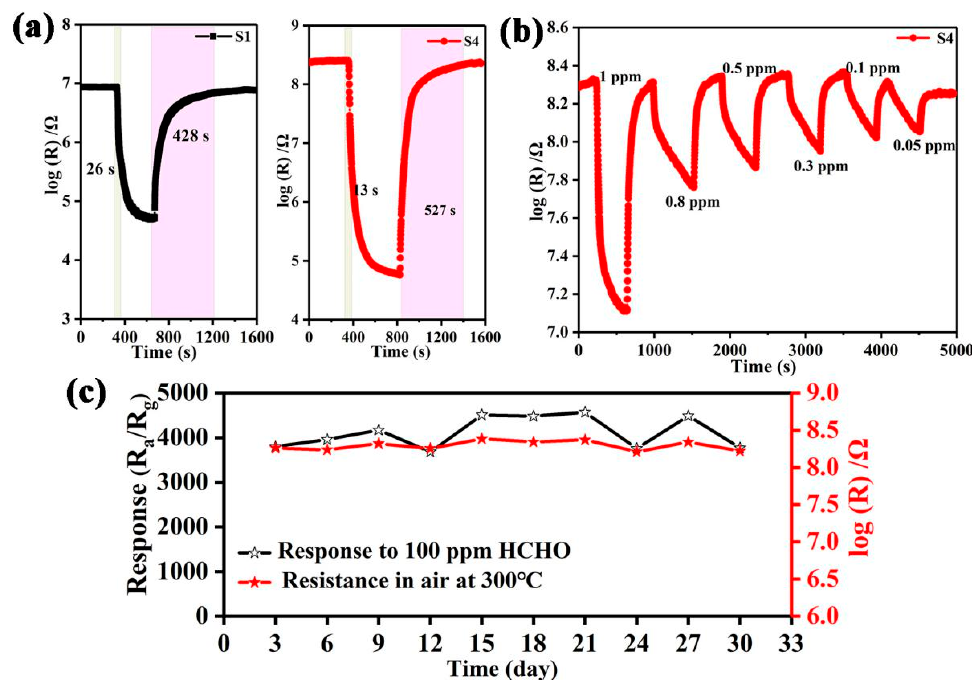
Figure 8. ( a ) Dynamic resistance transition of S1 and S4 toward 100 ppm of formaldehyde at 300 °C. ( b ) Dynamic resistance transition of S4 sensor (50 ppb–1ppm) at 300 °C. ( c ) Fluctuation of resistance and response values within 30 days of S4 toward formaldehyde. Table 1. Comparison of formaldehyde sensing properties in this work with other SnO 2 -based